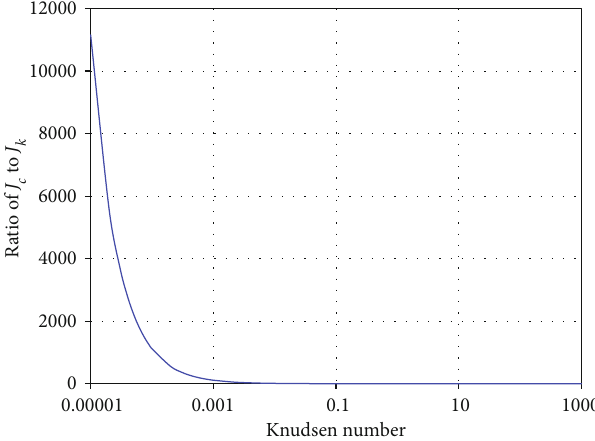
Figure 4: Ratio of continuous fl ow and Knudsen di ff usion with di ff erent Kn